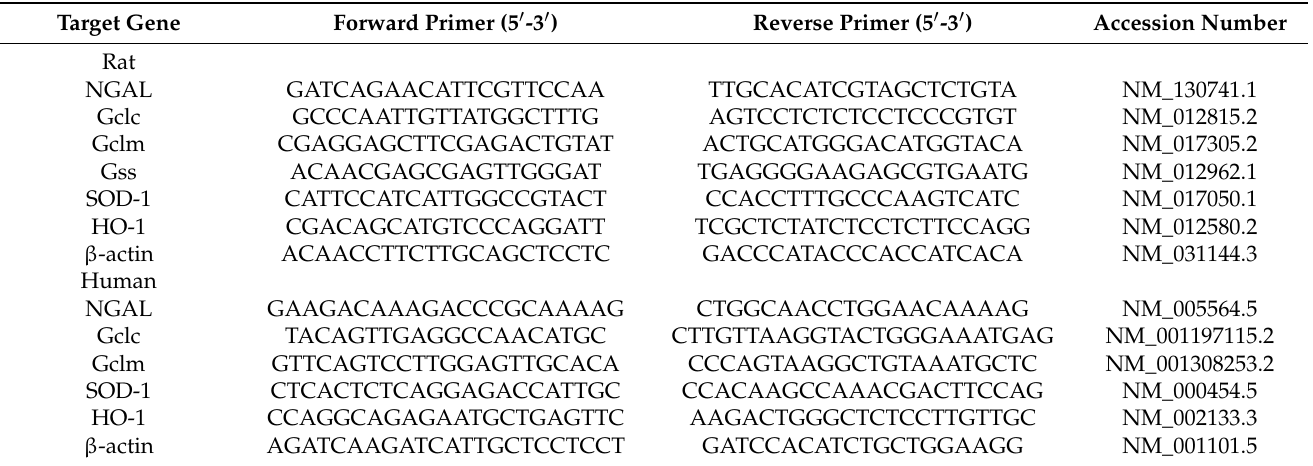
Table 1. Gene primer sequences of rat and human used for real-time